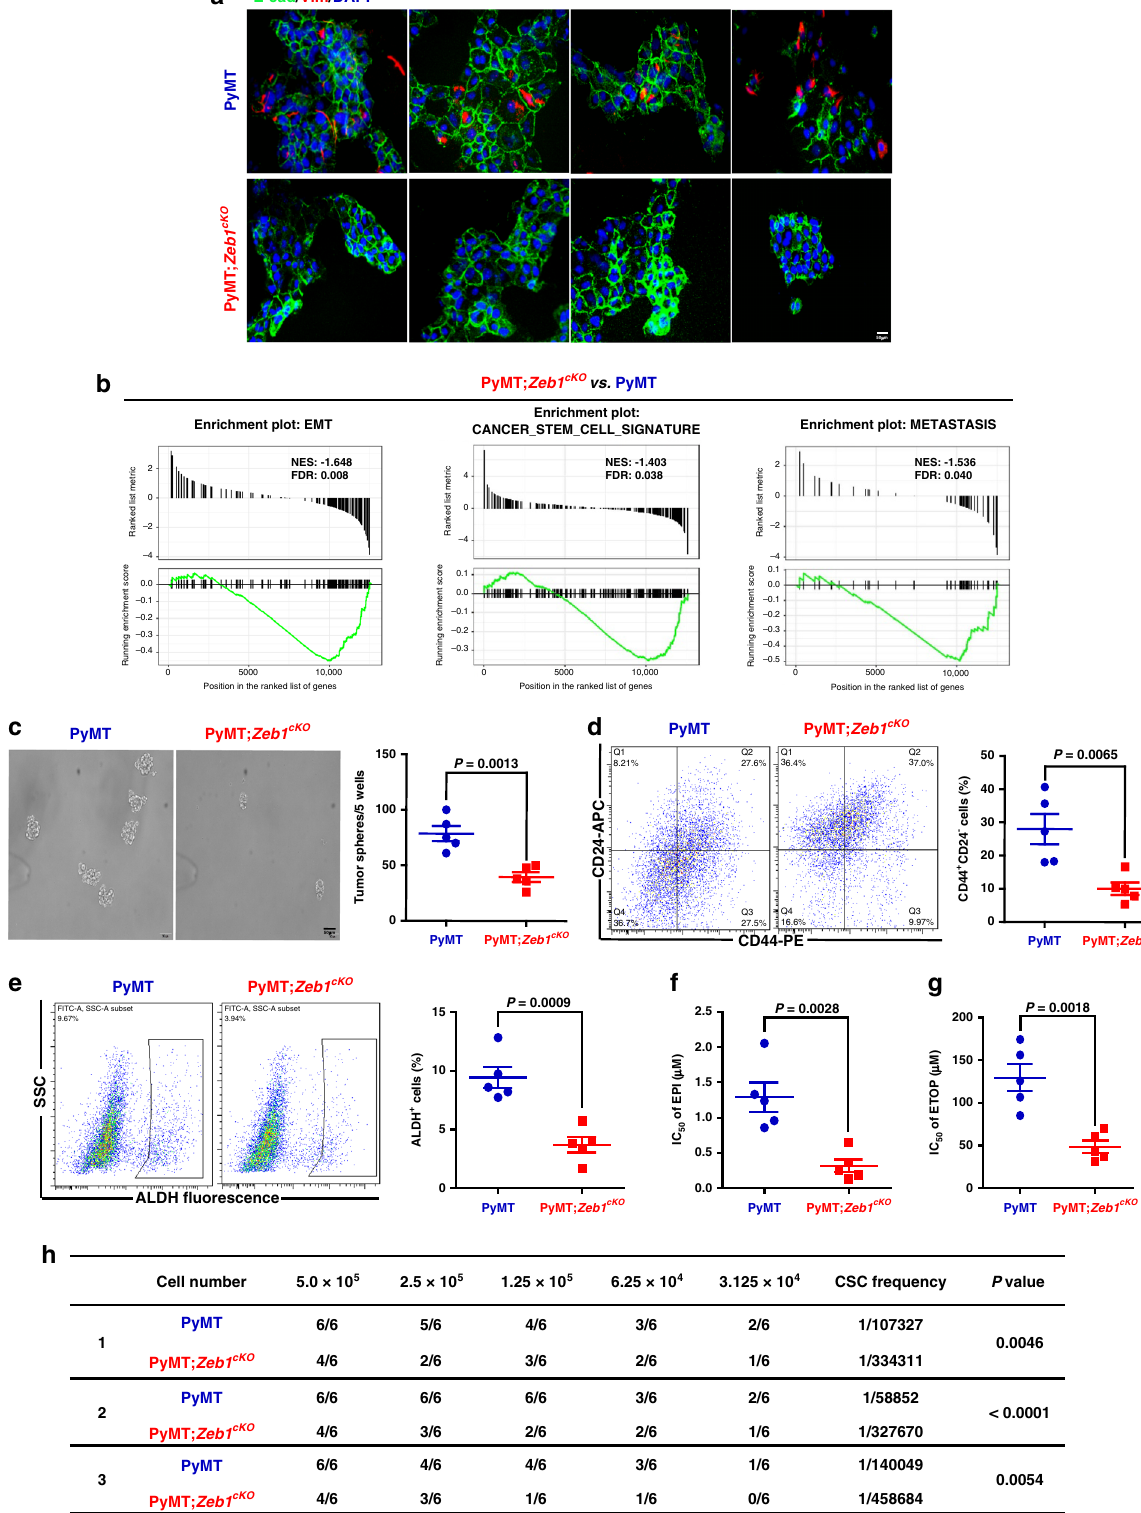
Enrichment plot: